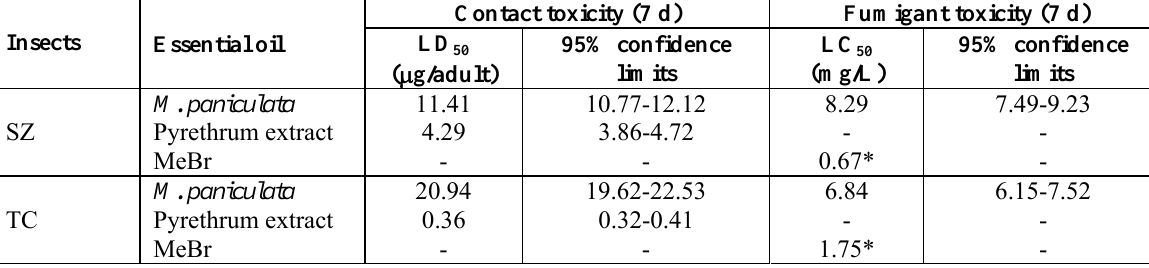
Table 2. Insecticidal activity of the essential oil of Murraya exotica against Sitophilus zeamais (SZ) and Tribolium castaneum (TC)